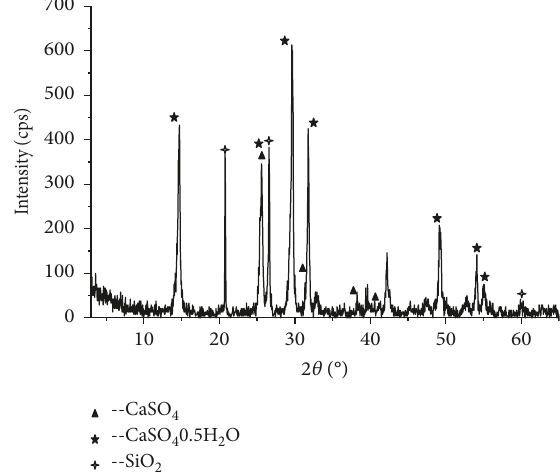
Figure 2: XRD pattern of phosphogypsum.